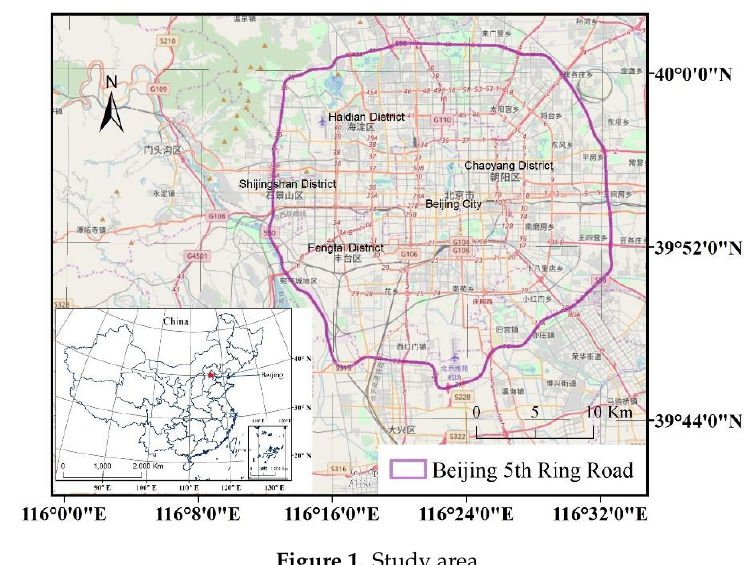
Figure 1. Study area.